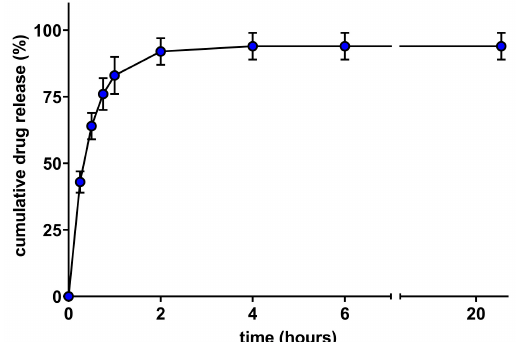
Figure 3. In vitro cumulative drug release study of TFB SqD NPs at pH 5.0 and 32 °C over 24 h. Results are presented as mean ± SD.